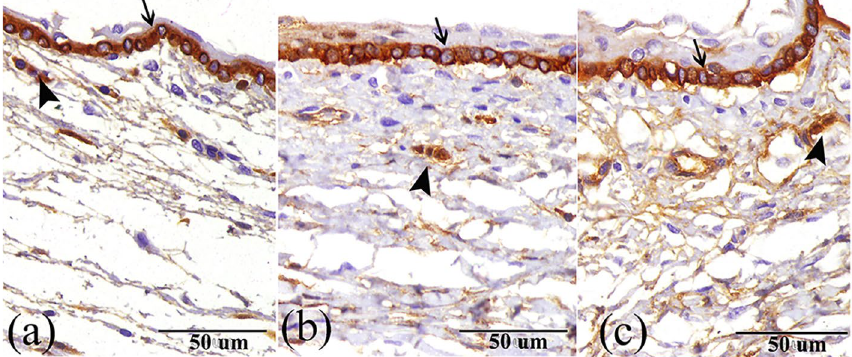
Figure 4. Immunohistochemical staining of the limbus to ck14 ( a ) At PND7, ( b ) At PND15, and ( c ) At PND30 showing positive immunoreactivity of the basal layer of the limbal epithelium (arrow) and the limbal epithelial stem cells clusters located within the underlaying stroma